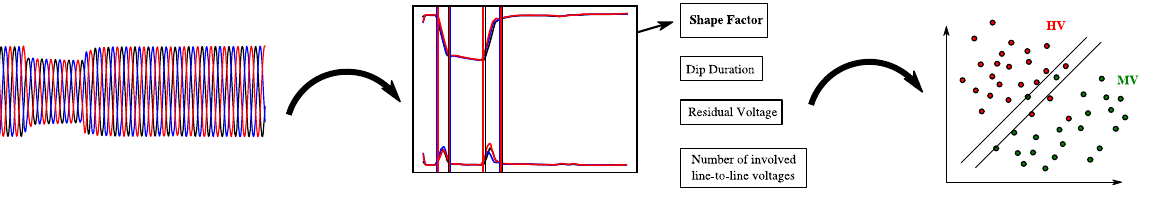
Figure 6. FExWaveS Figure 6. FExWaveS architecture.